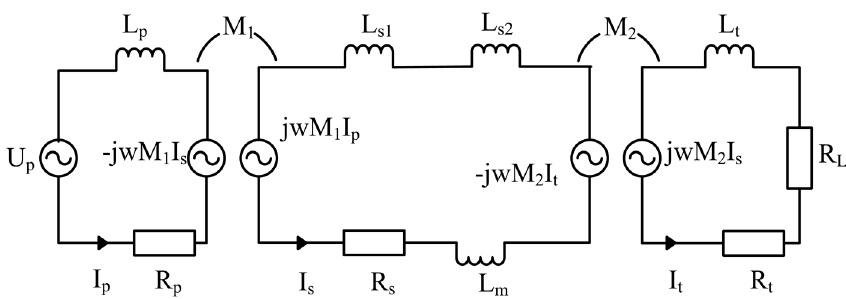
Figure 7. System model . Figure 7. System